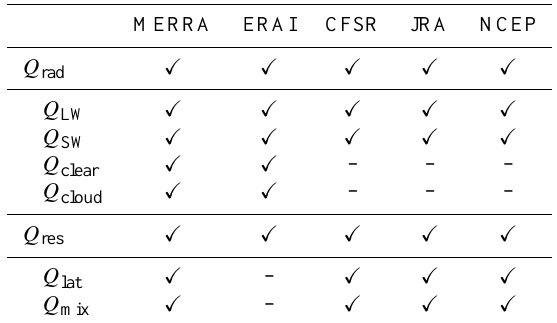
Table 2. Availability of diabatic heating components for each re-